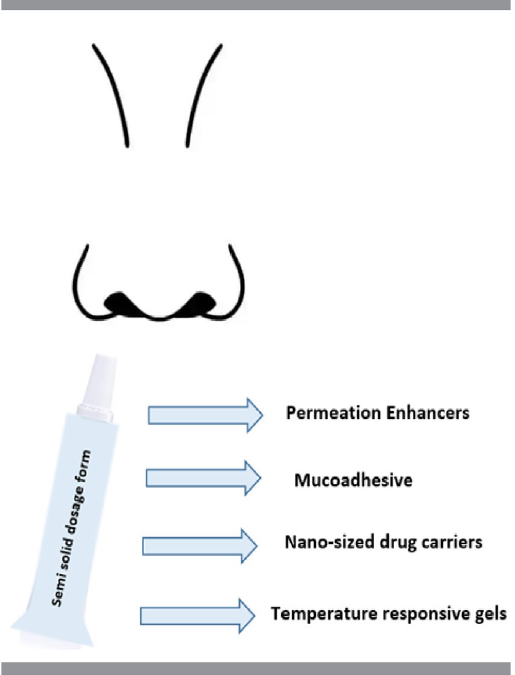
Figure 3. Different semi-solid formulations for nasal administration.